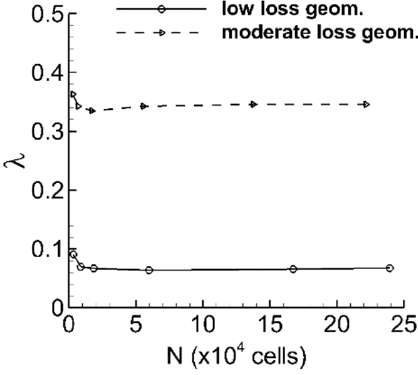
Figure 9. Model 1 grid convergence study.